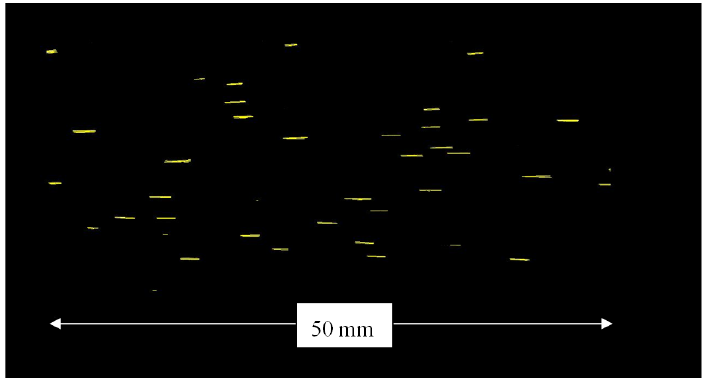
Figure 11. Figure 10 cropped and analyzed for particle velocities. A yellow streak was placed over the length of each particle streak the program